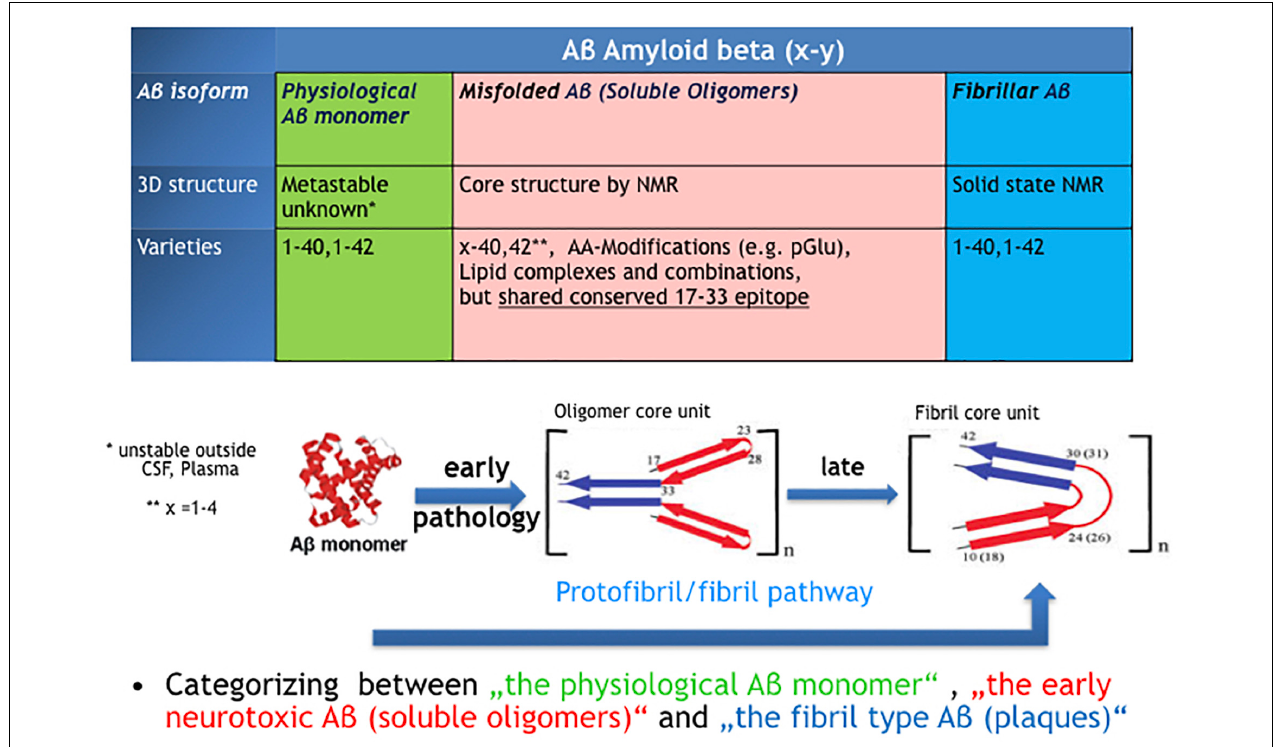
FIGURE 1 | The confusion around the peptide “Amyloid beta, A β .” Three very different types of protein assemblies sharing the same name.